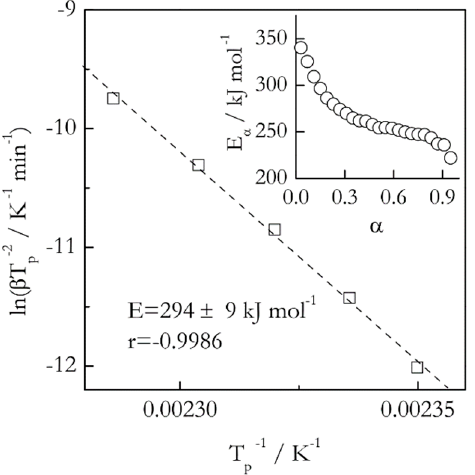
Figure 7. Kissinger plot for melting of glucose. Dash line is least square fit to experimental data (squares). Inset shows variation in isoconversional activation energy (circles). The heating rate range 1–11 °C min − 1 . Data from Liavitskaya et al. [67]. Reproduced from Ref. [67] with permission from the PCCP Owner Societies.